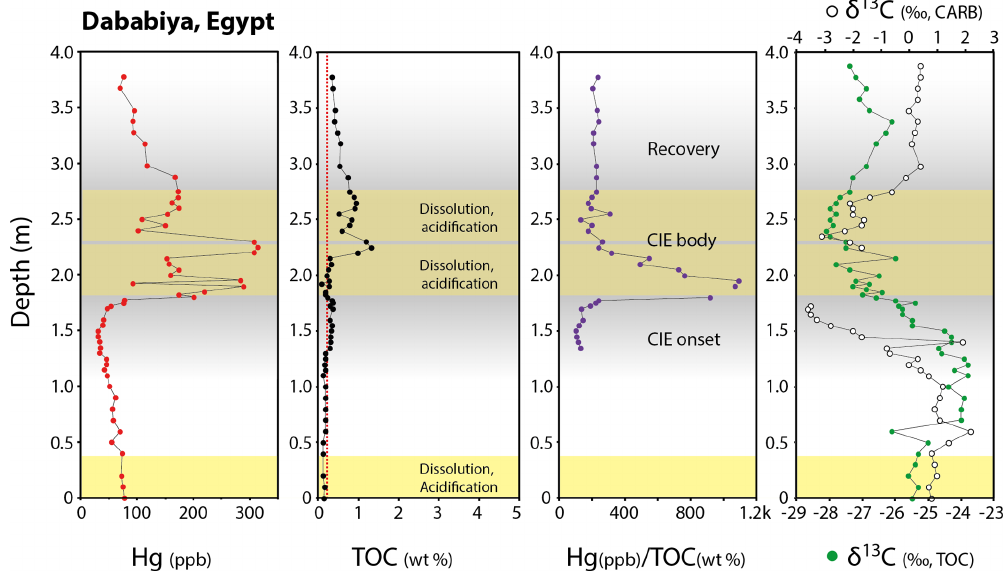
Figure 9. Mercury, TOC, Hg / TOC, δ 13 C CARB , and δ 13 C TOC data from the Dababiya GSSP locality in Egypt (Keller et al., 2018). The colouring scheme is the same as in Fig. 3, with the addition of δ 13 C CARB data shown as white points. The red dashed line in the TOC graph denotes the recommended threshold for TOC concentrations to report Hg / TOC values (Grasby et al., 2016). Samples with TOC values below this threshold were omitted from the Hg / TOC graph. Yellow bands denote sections of stratigraphy heavily affected by dissolution and acidification (Keller et al.,